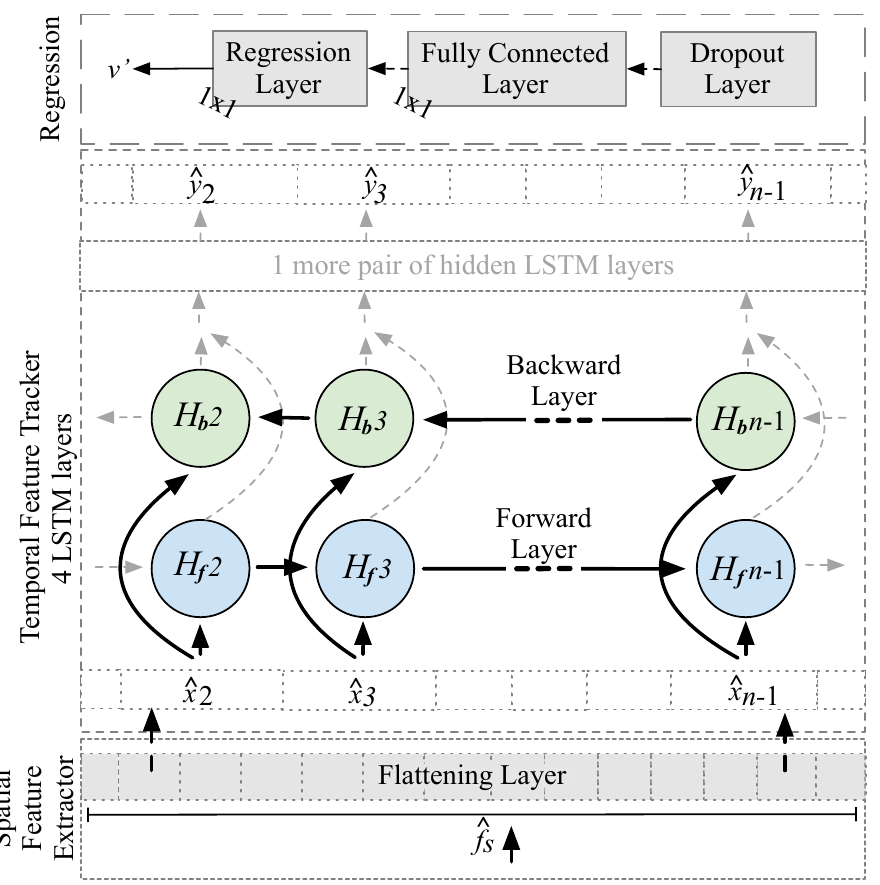
Figure 5. “Temporal feature tracker” built from two BLSTMs, each with two hidden f orward ( H f ) and b ackward ( H b ) long-short-term-memory (LSTM) layers (only one shown; no LSTMs for ˆ x 1 and ˆ x n